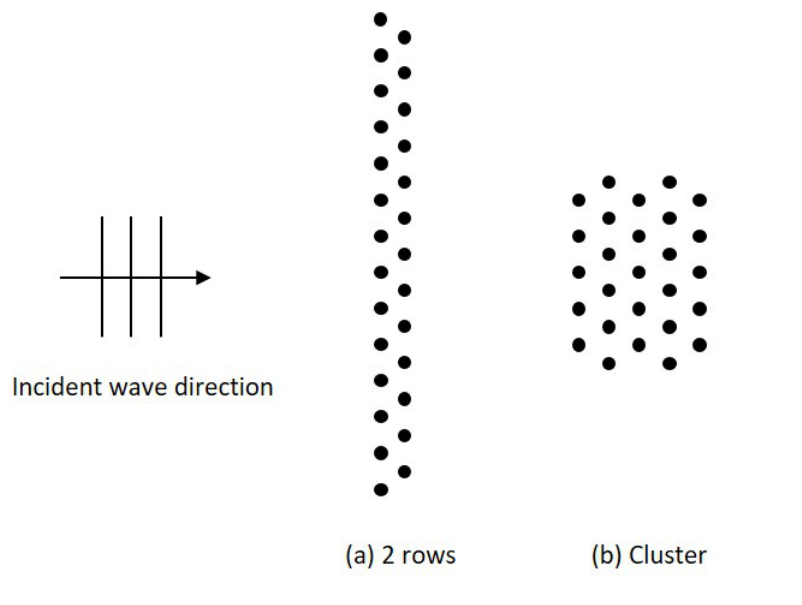
Figure 4. WEC array configurations were considered in this study: ( a ) two rows of WECs and ( b ) a cluster of